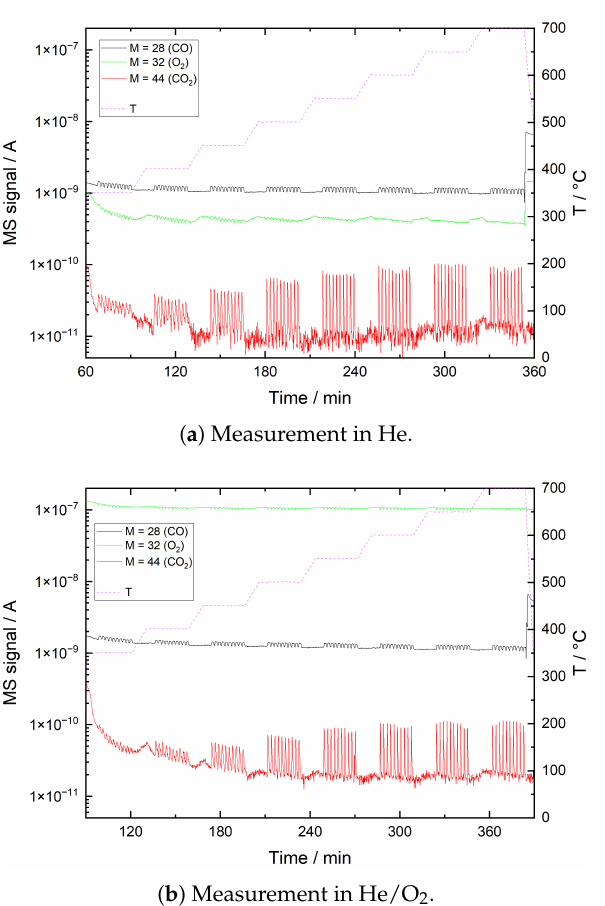
Figure 14. CO pulse measurement, ITO powder, recorded in ( a ) He and ( b ) He +12.5vol% O 2 (He/O 2 ) at 8 different temperature levels. The plots show mass spectrometer signals for mass numbers 28 (CO), 32 (O 2 ) and 44 (CO 2